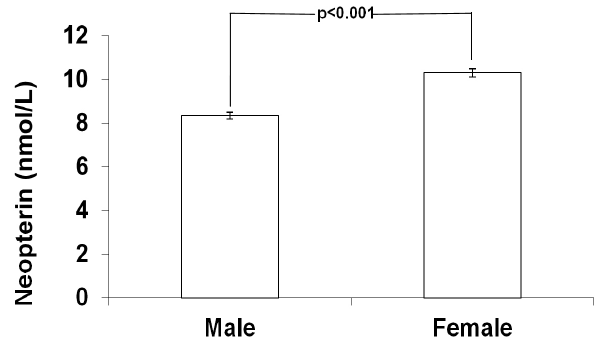
Figure 1: Neopterin levels (mean +/- SEM) in patients with HBsAg (+) and control.